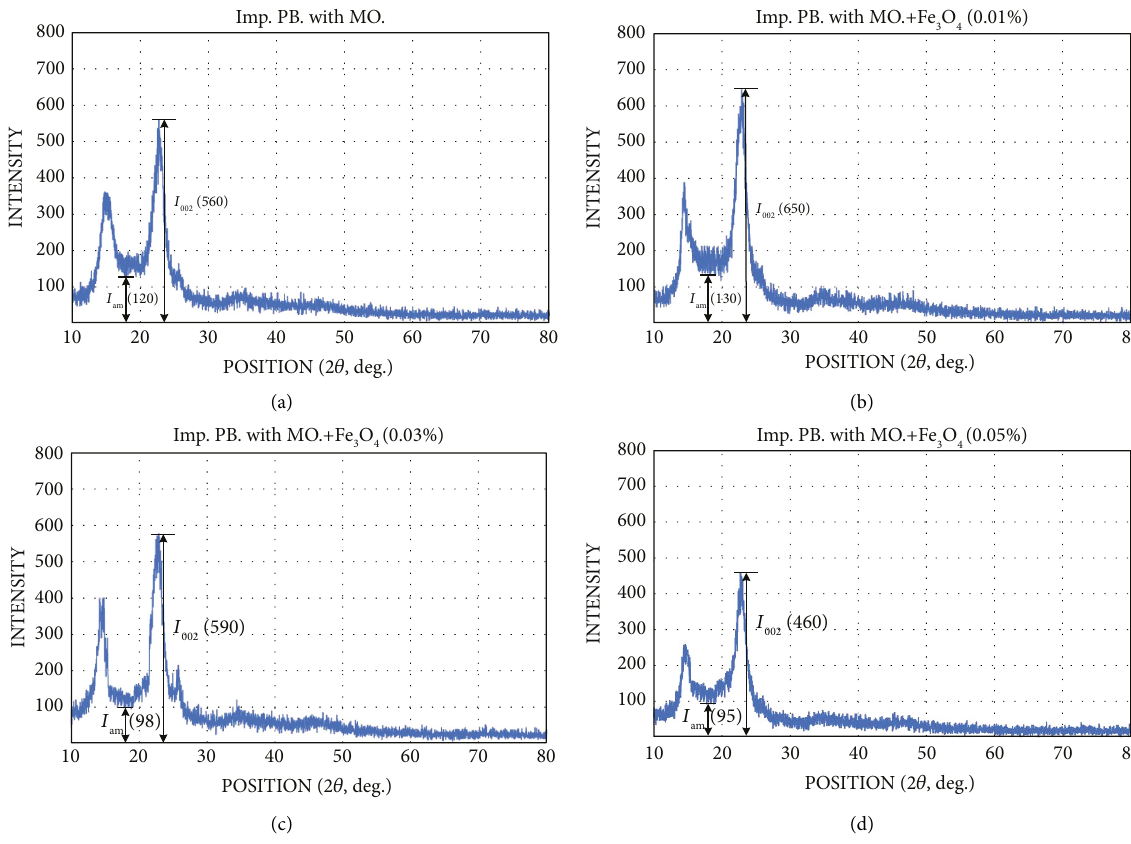
Figure 8: X-ray diffraction (X-RD) of the impregnated pressboard. (a) X-RD pattern of impregnated pressboard with conventional mineral oil. (b) X-RD pattern of impregnated pressboard with mineral oil-based Fe 3 O 4 (0.01%). (c) X-RD pattern of impregnated pressboard with mineral oil-based Fe 3 O 4 (0.03%). (d) X-RD pattern of impregnated pressboard with mineral oil-based Fe 3 O 4 (0.05%). Table 4: Results of the intensity and relative crystallinity of the impregnated